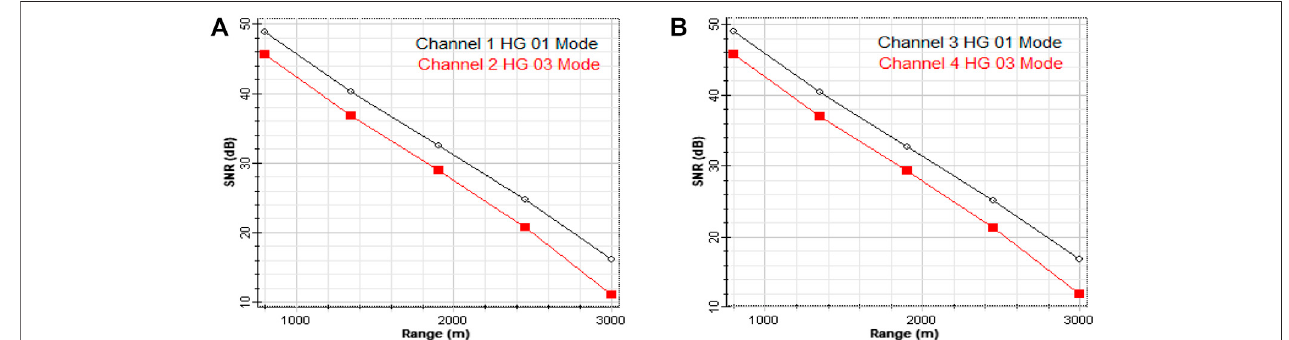
FIGURE 8 | SNR plots for (A) 1931. THz channel and (B) 193.2 THz channel under low fog.